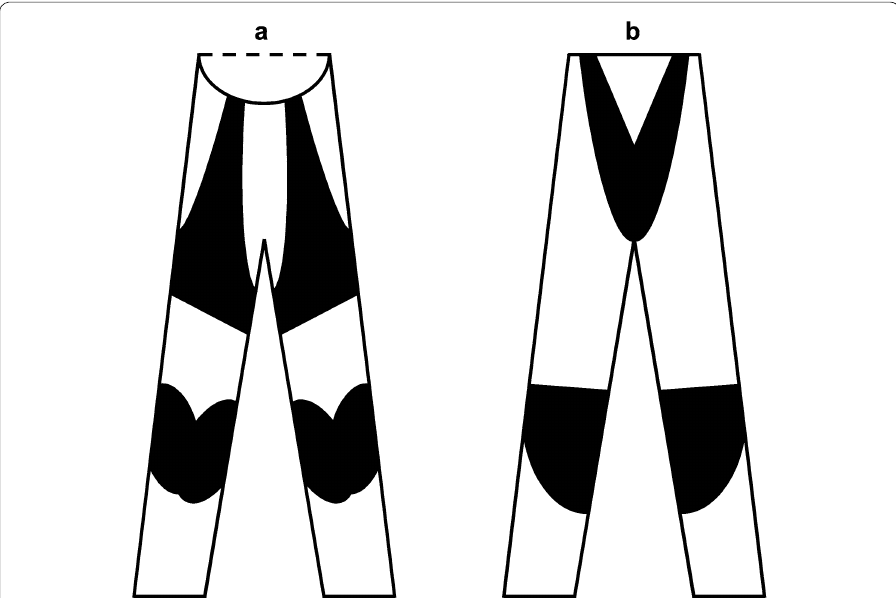
Fig. 1 Schematic image of P INSUL indicating the position of the additional insulation pads placed on the inside at the front ( a ) and rear ( b ) face. The pads were placed to cover the gluteal, knee extensor, ankle dorsi- and plantar flexor muscles and covered ~ 30% of the surface of P INSUL. P COOL (not pictured) had the same cut and was made of the same base material as P INSUL but was designed without additional